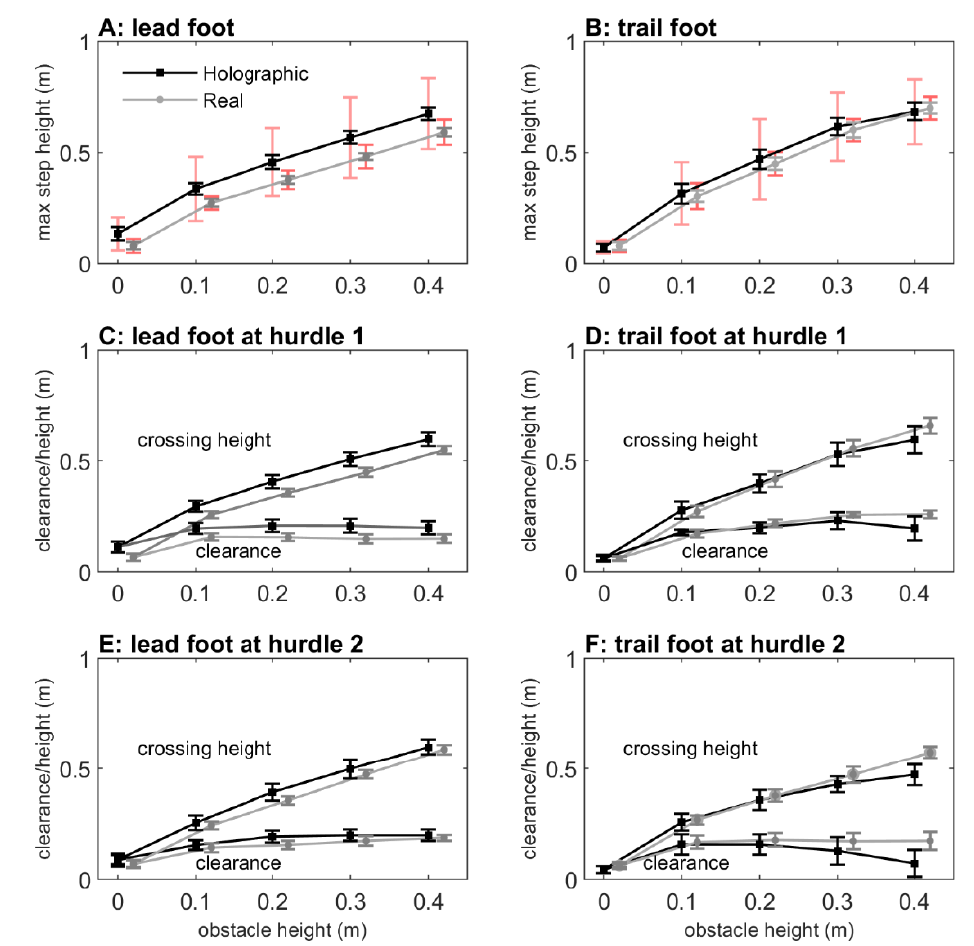
Figure 6. Maximum step height for lead (panel A ) and trail foot (panel B ), including indications of the within-subject (gray and black) and between-subject standard deviation (red; much greater for holographic than real obstacles). The crossing height and foot clearance at hurdle 1 for lead (panel C ) and trail foot (panel D ), including indications of within-subject variability (gray and black). Likewise at hurdle 2 (panels E and F ). Note that participants 1, 8, and 11, who did not raise their trail foot for holographic obstacles, were excluded from panels B, D, and F.